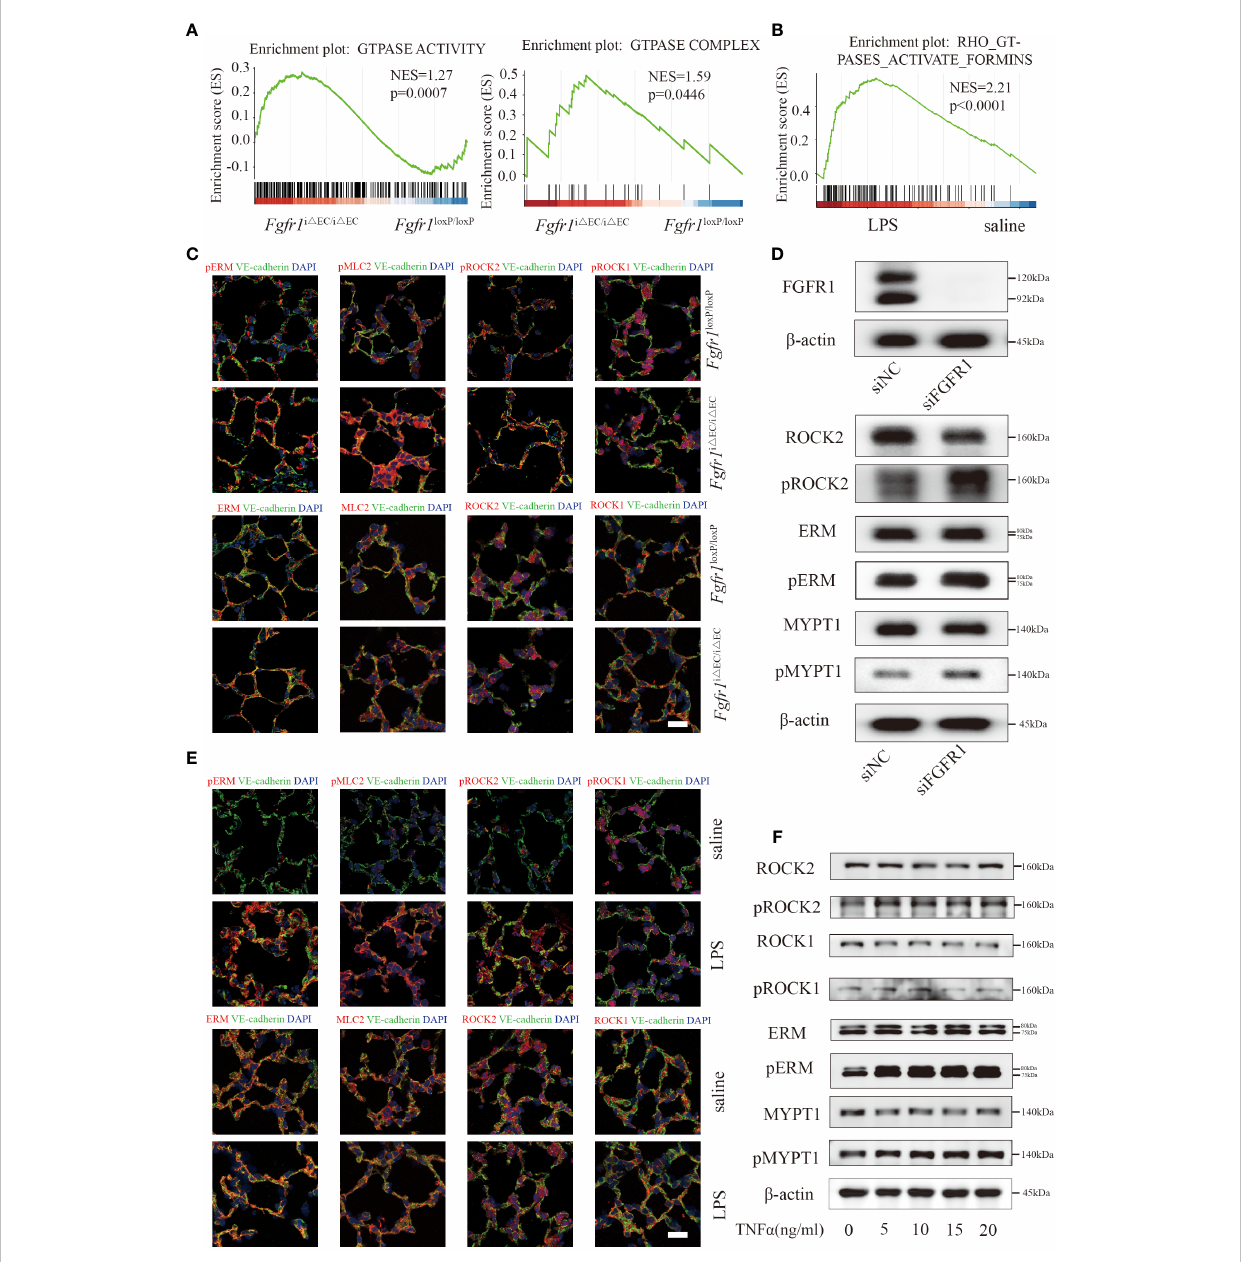
FIGURE 3 Endothelial ROCK2 was activated in ALI/ARDS model and functioned as a downstream of FGFR1. RNA-seq analysis was performed on ECs isolated from LPS-treated Fgfr1 i D EC/i D EC mice and Fgfr1 loxP/loxP mice. Gene set enrichment analysis of differentially expressed genes showed enrichment of GTPase activity and the GTPase complex (A) , which are related to RhoA activation. RhoA GTPase activation was enriched by GSEA in the LPS group compared with the saline group (B) . Endothelial ROCK2 activity was assessed by the colocalization of pERM, ERM, pMLC2, MLC2, pROCK2, ROCK2, pROCK1 and ROCK1 (red fl uorescent protein) with VE-cadherin (green fl uorescent protein) by immuno fl uorescent staining. Representative images of immuno fl uorescent staining of endothelial ROCK2 activity in the Fgfr1 i D EC/i D EC mice vs the Fgfr1 loxP/loxP mice group (C) and the saline vs LPS group (E) are shown. n=3 per group. Scale bars: 40 µm. HUVECs were transfected with siNC or siFGFR1 for 48 h. The expression of FGFR1 after siRNA transfection was detected by WB with FGFR1 and b -actin antibodies. The phosphorylation of ERM, MYPT1 and ROCK2 was assessed (D) . In addition, HUVECs were treated with 0, 5, 10, 15 and 20 ng/ml of TNF a for 12 h, and ROCK2 activity was assessed by WB (F)